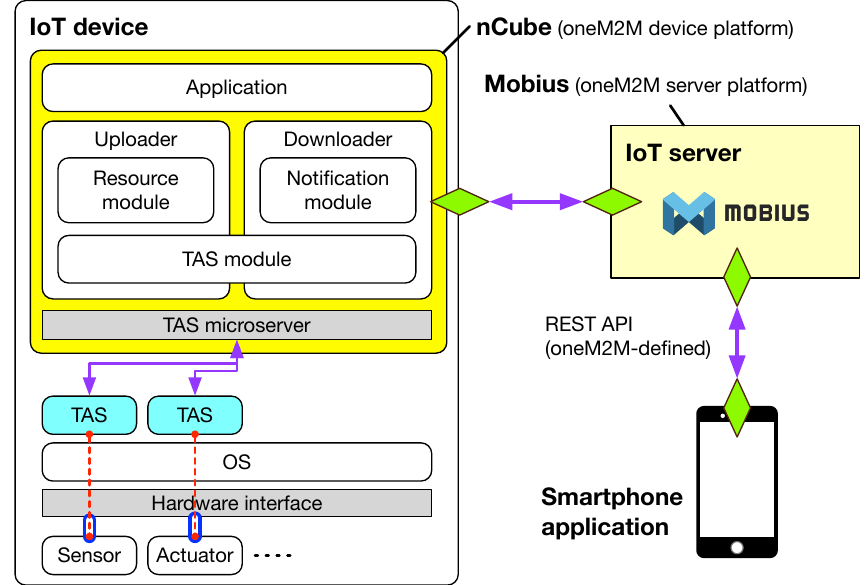
Figure 4. The architecture for the oneM2M middleware